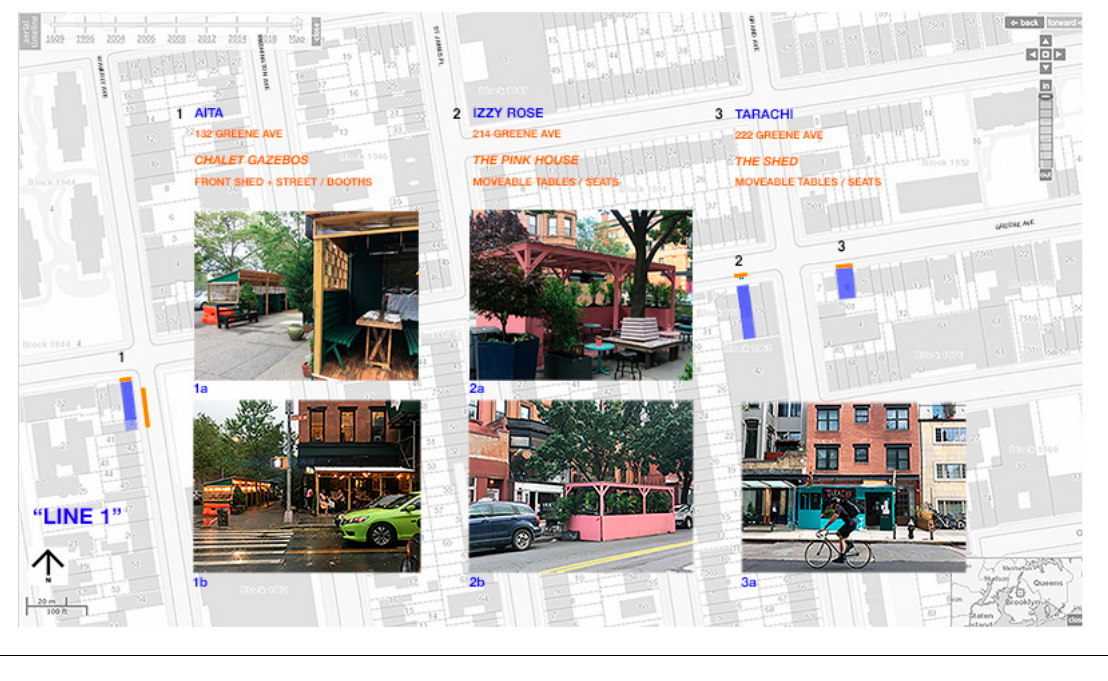
Figure 6. Western half of the Line: Aita, Izzy Rose and Tarachi present inventive street choices: orange denotes street constructions, blue denotes indoor parcel (Source: author)